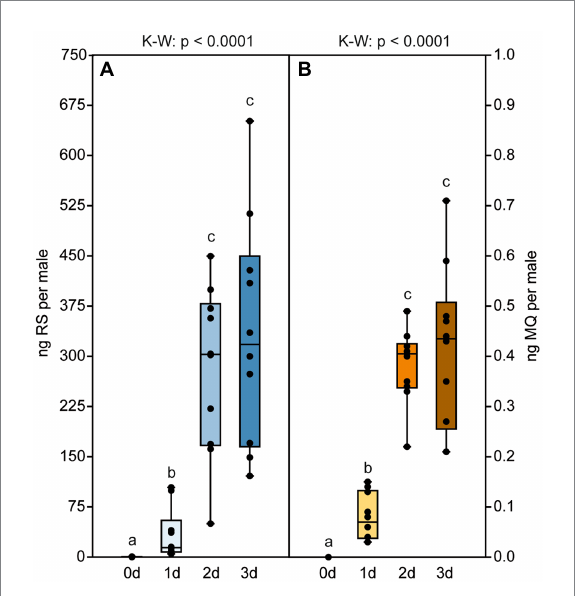
FIGURE 2 Pheromone titers of N. longicornis males are age dependent. Amounts of (A) (4 R ,5 S )-5-hydroxy-4-decanolide (RS) and (B) 4-methylquinazoline (MQ) in abdomen extracts from N. longicornis males of various age. Box and whisker plots show median (horizontal line), 25%–75% quartiles (box), maximum/ minimum range (whiskers) and outliers ( ° >1.5 × above box height; *>3 × above box height). Different lowercase letters indicate significant differences between the ages at p < 0.001 [ n = 10, data analysis by a Kruskal–Wallis H -test (K–W) followed by multiple Bonferroni-corrected Mann–Whitney U